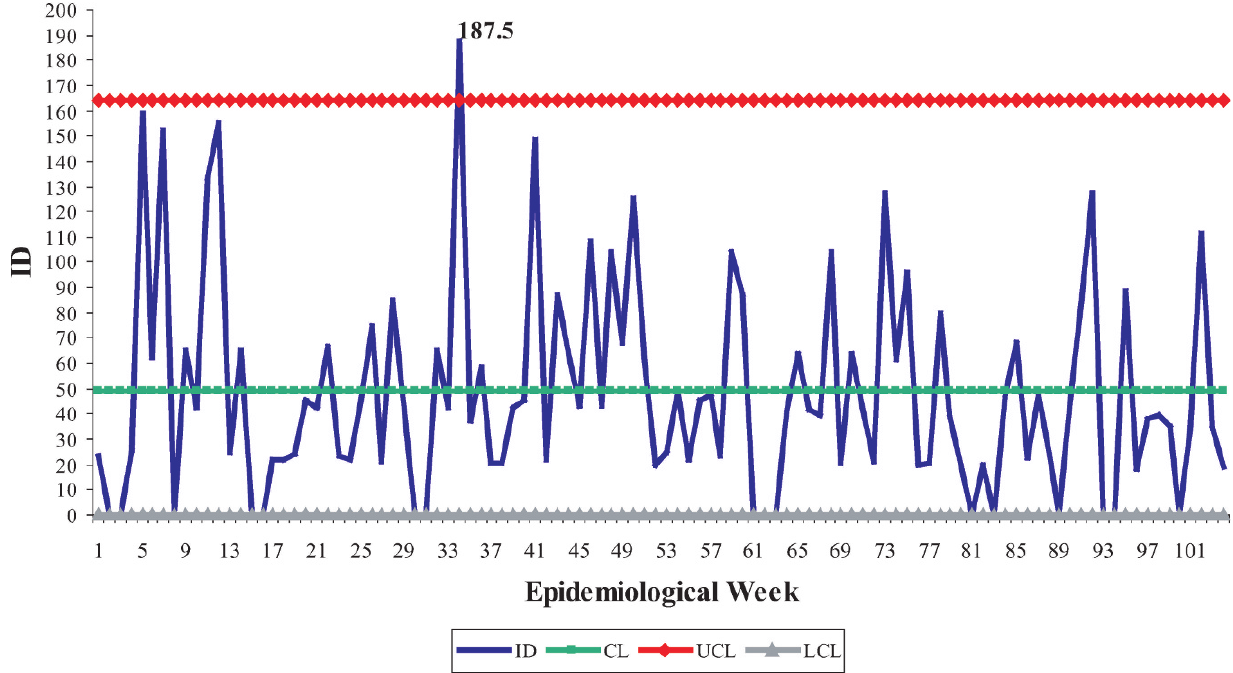
Figure 2 - The control chart of incidence densities per 1,000 patients/day in 2004 and 2005 (traditional Shewhart chart). (1) The mean value of the incidence densities and the module of moving ranges were 48.78 and 43.39, respectively. (2) The limit values were CL=48.78, LCL=0, and